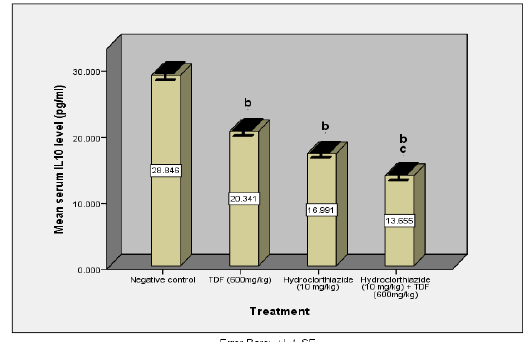
Figure 2. Effect of different treatments on interleukin-10 level in serum of rats' groups ( b ):-Indicate a significant difference (P<0.05) compared to negative control